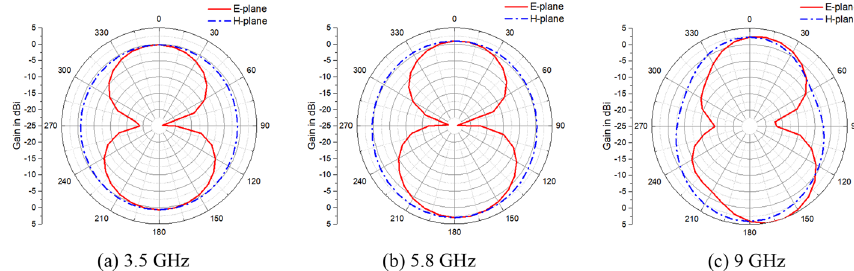
Fig. 7 E-plane and H-plane simulated radiation pattern. a – c The simulated radiation values produced by the antenna in the E and H-planes at the frequencies of 3.5 GHz, 5.8 GHz, and 9 GHz, respectively